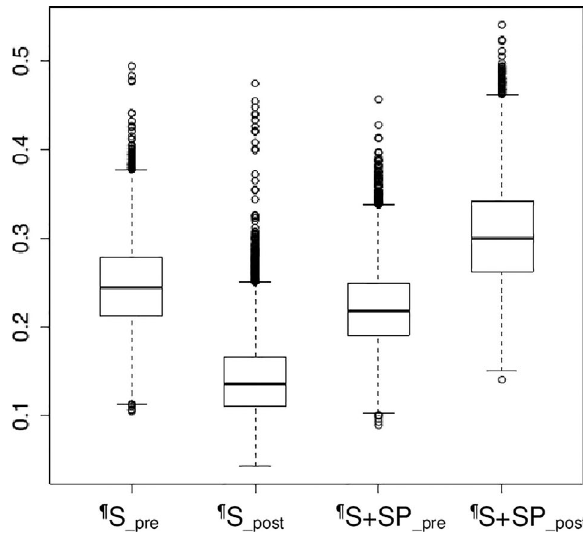
Figure 6 - Box plot of the posterior probability of volleyball perfect dig with displacement in the Skill (S) and Skill and strength/power (S+SP) groups in the pre- and post-training assessments